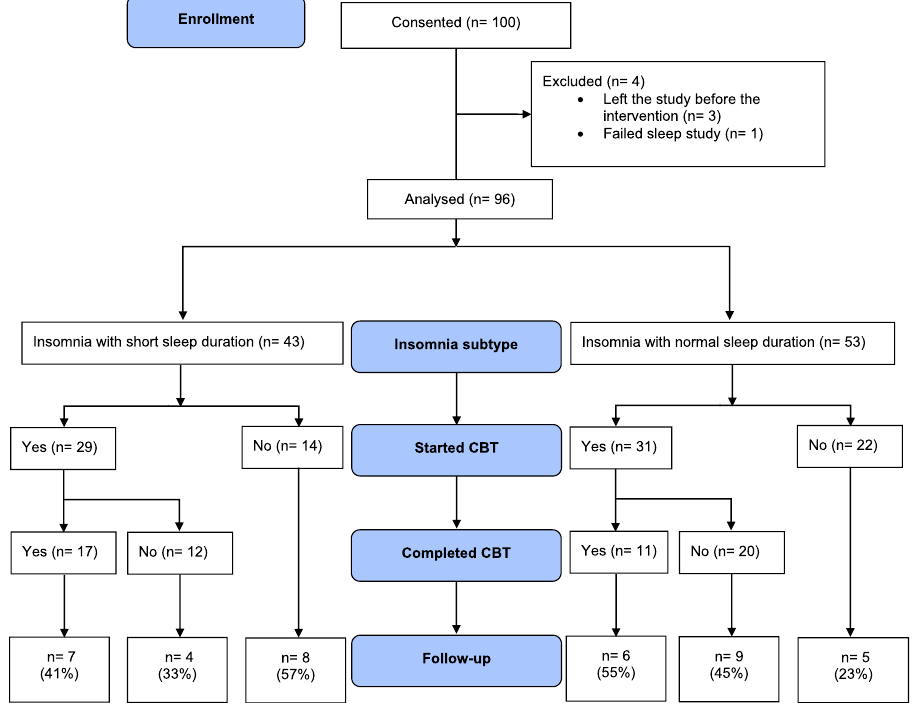
Figure 1. Study flow diagram with results of participants by insomnia subtype through psychotherapy treatment for Insomnia Disorder. The follow-up section displays the number (%) of participants who completed this assessment by insomnia subtype. CBT: Cognitive behavioural therapy; I-NSD: Insomnia with normal sleep duration; I-SSD: Insomnia with short sleep duration.